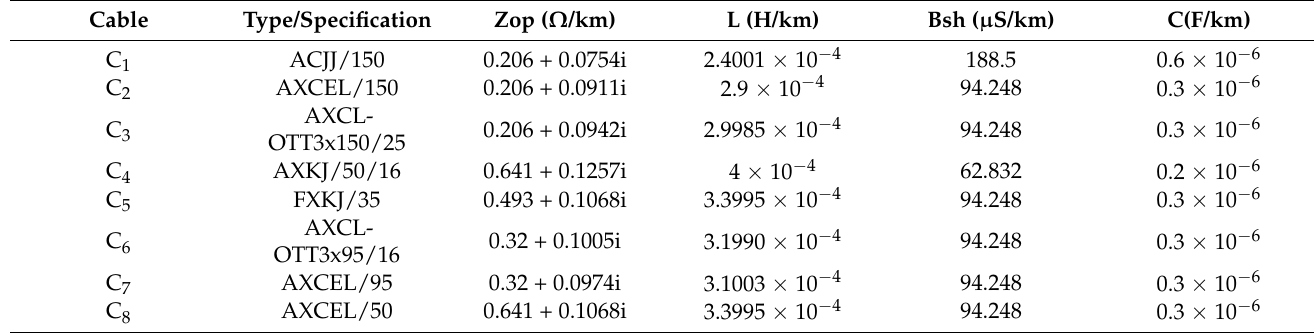
Table A1. Cable parameters.